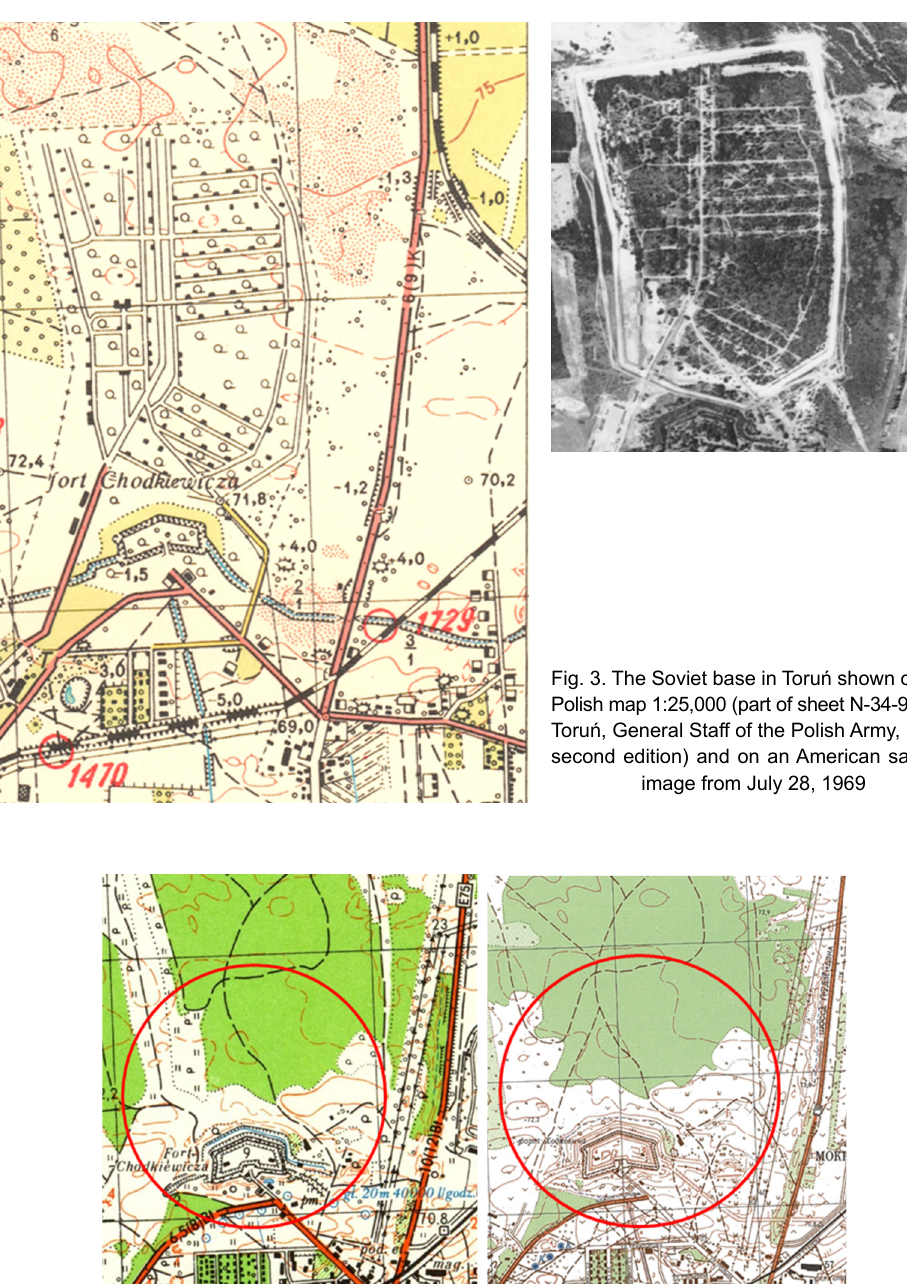
Fig. 4. A comparison of camouflaging of the same facility on maps at different scales: on the left − a part of the Polish map 1:25,000 (sheet N-33-98-C-c Toruń), 1988, updated from 1986–1987; on the right − a part of the Soviet map 1:10,000, 1986, updated from 1982. Neither map shows the Soviet base, and despite the different scales of the maps, the same camouflaging method was